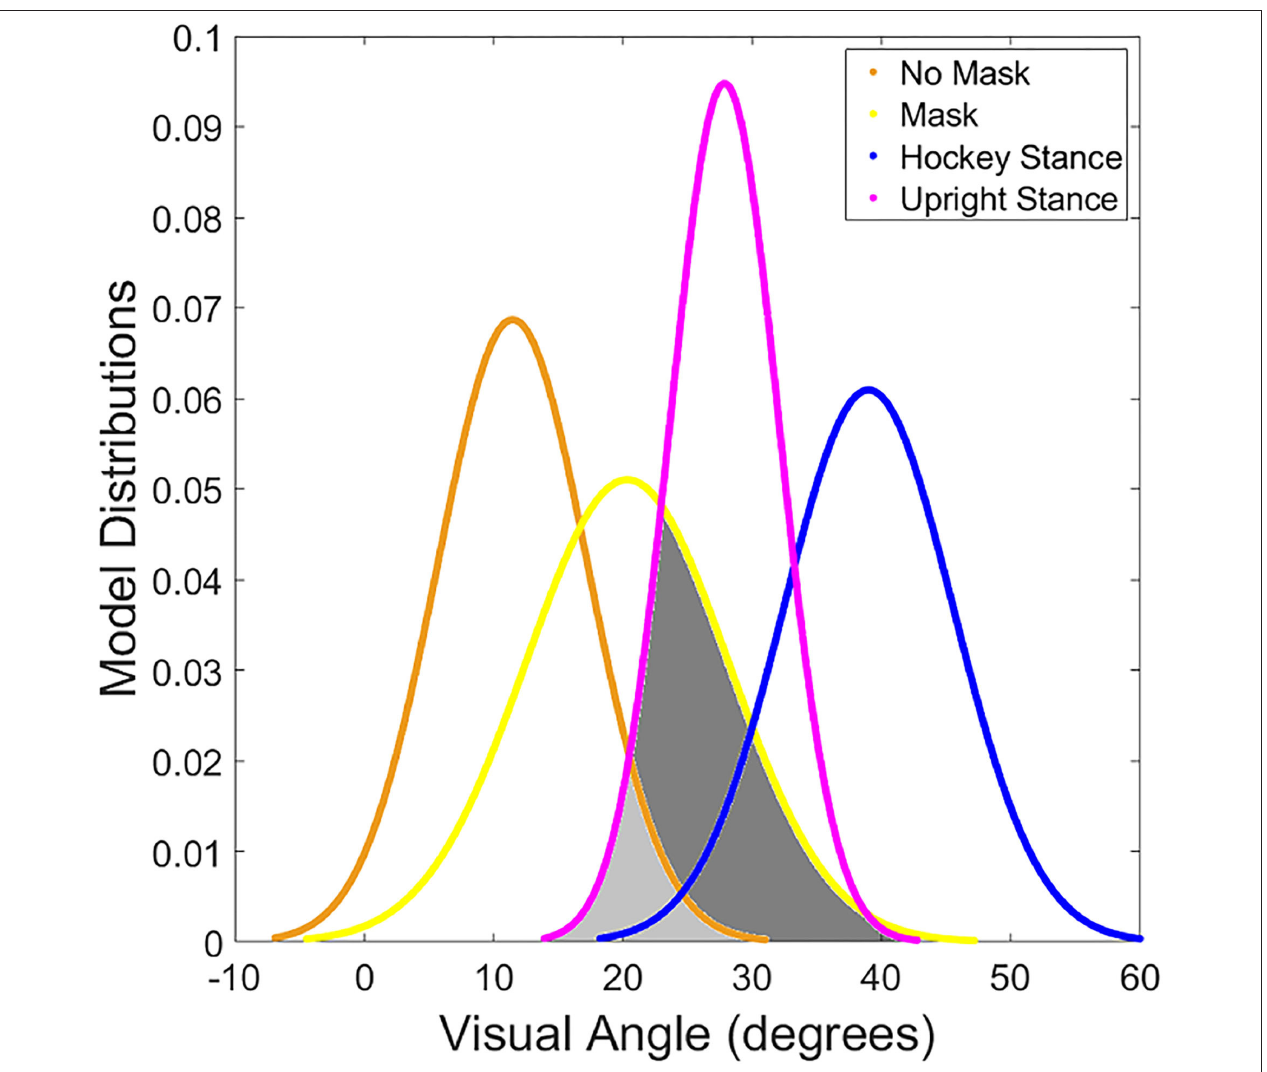
FIGURE 4 | Depicts the distribution of visual thresholds determined for each model. The yellow (FM condition) and orange (No mask) lines illustrate the range of visual angles based on the empirical visual angle threshold data. The purple (upright stance) and blue (hockey stance) lines show the range of visual angles for the cohort across the height conditions. Where the orange or yellow line overlaps the blue or purple line (shaded in light and dark gray for emphasis) represents circumstances where the puck on the stick would not be visible without tilting the head